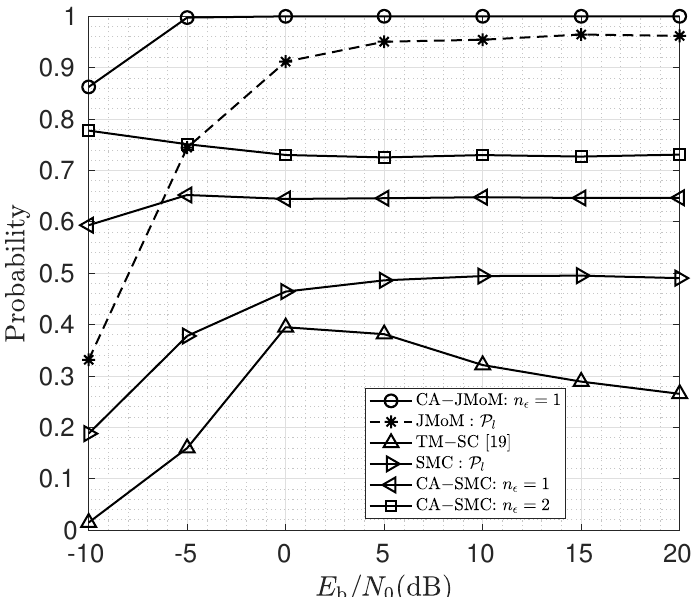
Figure 1. Lock-in probability of the proposed estimators for different values of E b / N 0